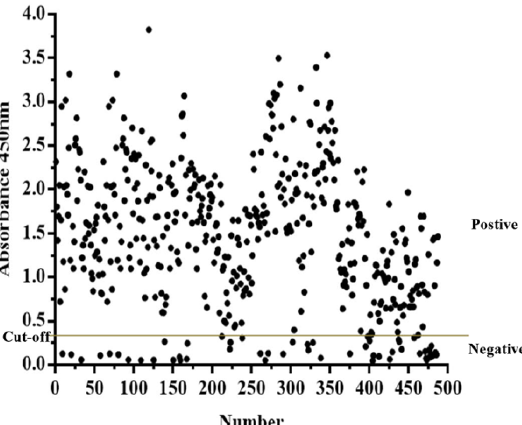
Figure 7. PPV-VLP-ELISA was employed to screen clinical swine serum samples ( n = 487).